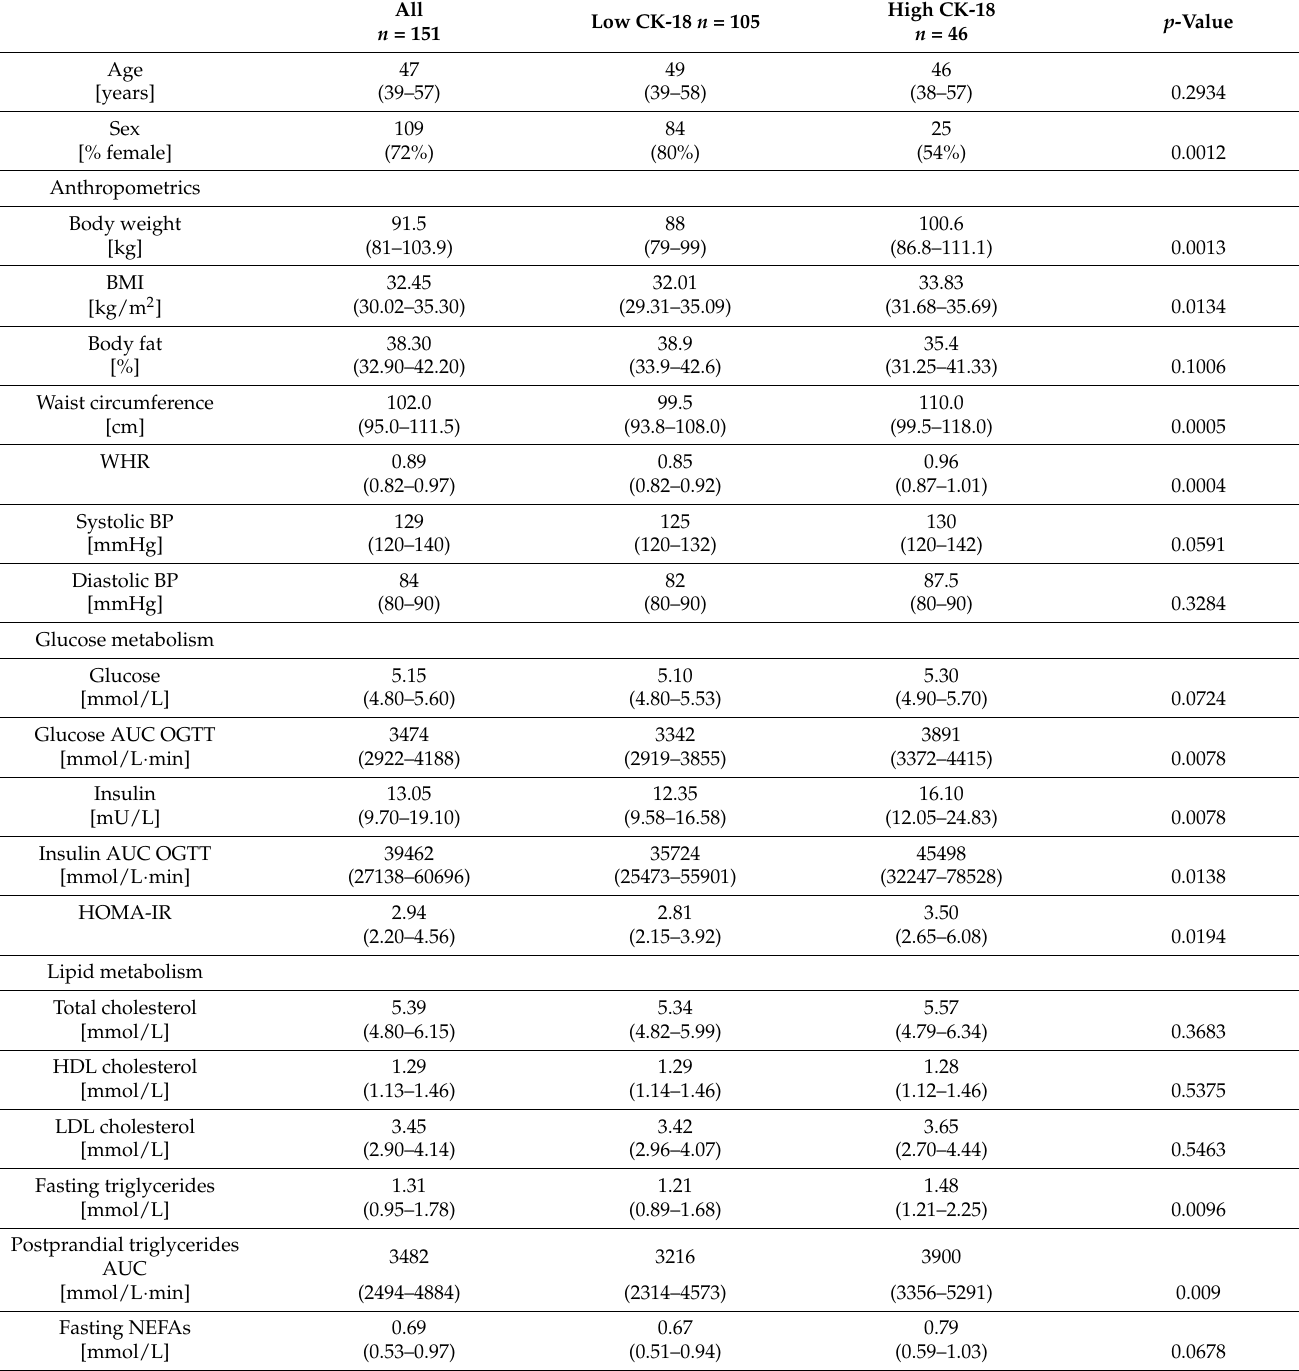
Table 1. Characteristics of subjects included in the study: comparison of groups according to the cytokeratin-18 plasma